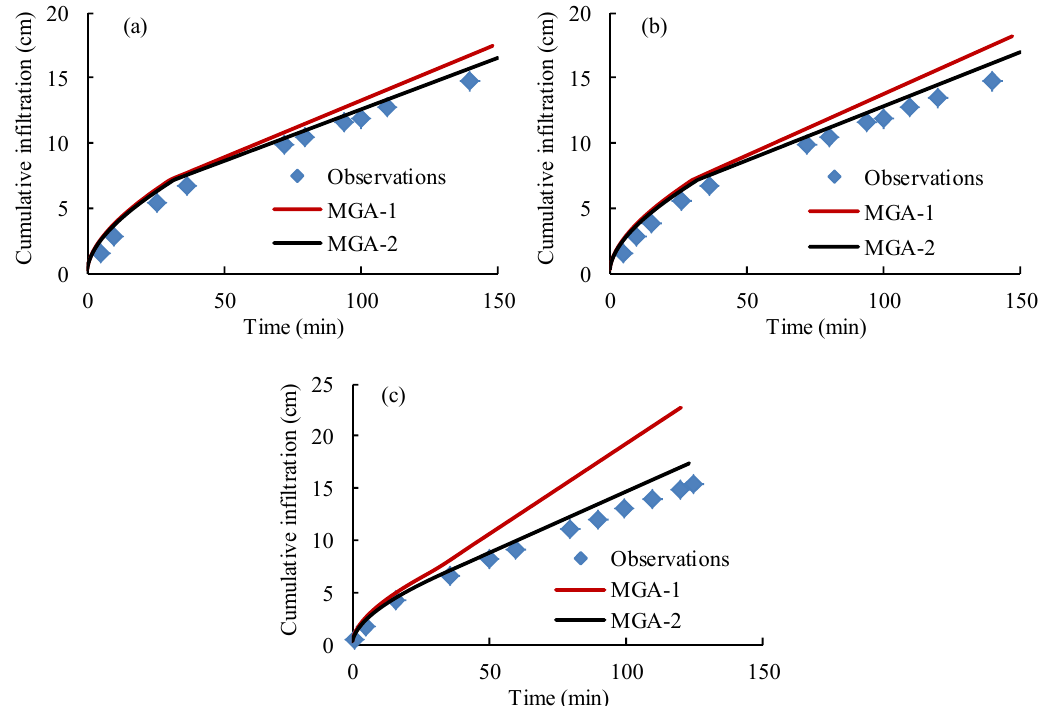
Figure 9. Comparison of the observed cumulative infiltration and the calculated value with the